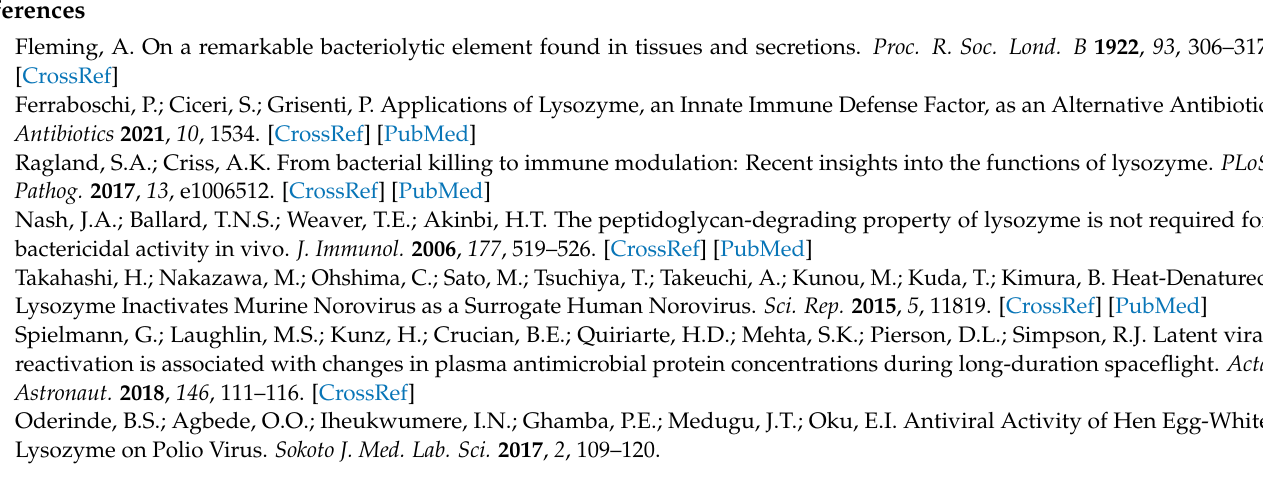
Figure S5: Deconvolution HRMS spectra of heat-treated lysozyme HCl; Figure S6: Superimposed 1H-13C HSQC spectra recorded in D2O of native lysozyme HCl (red) and heat-treated lysozyme HCl (blue); Figure S7: Superimposed 13C NMR spectra recorded in D2O of native lysozyme HCl (blue) and heat-treated lysozyme HCl (red); Figure S8: Superimposed 1H NMR spectra recorded in H2O/D2O 9:1 of native lysozyme HCl (blue) and heat-treated lysozyme HCl (red); Figure S9: Superimposed 1H-15N HSQC spectra recorded in H2O/D2O 9:1 of native lysozyme HCl (red) and heat-treated lysozyme HCl (blue); Figure S10: Superimposed 13C MAS spectra of native lysozyme HCl (blue) and heat-treated lysozyme HCl (red); Figure S11: Superimposed 13C CP MAS spectra of native lysozyme HCl (blue) and heat-treated lysozyme HCl (red); Figure S12: Graphical representation of Zp values measured at different pH of native lysozyme HCl (on the left) and heat-treated lysozyme HCl (on the right); Figure S13: CD spectra of lysozyme HCl (left) and heat-treated lysozyme (right) in water (0.5 mg/mL); Figure S14: SDS-PAGE